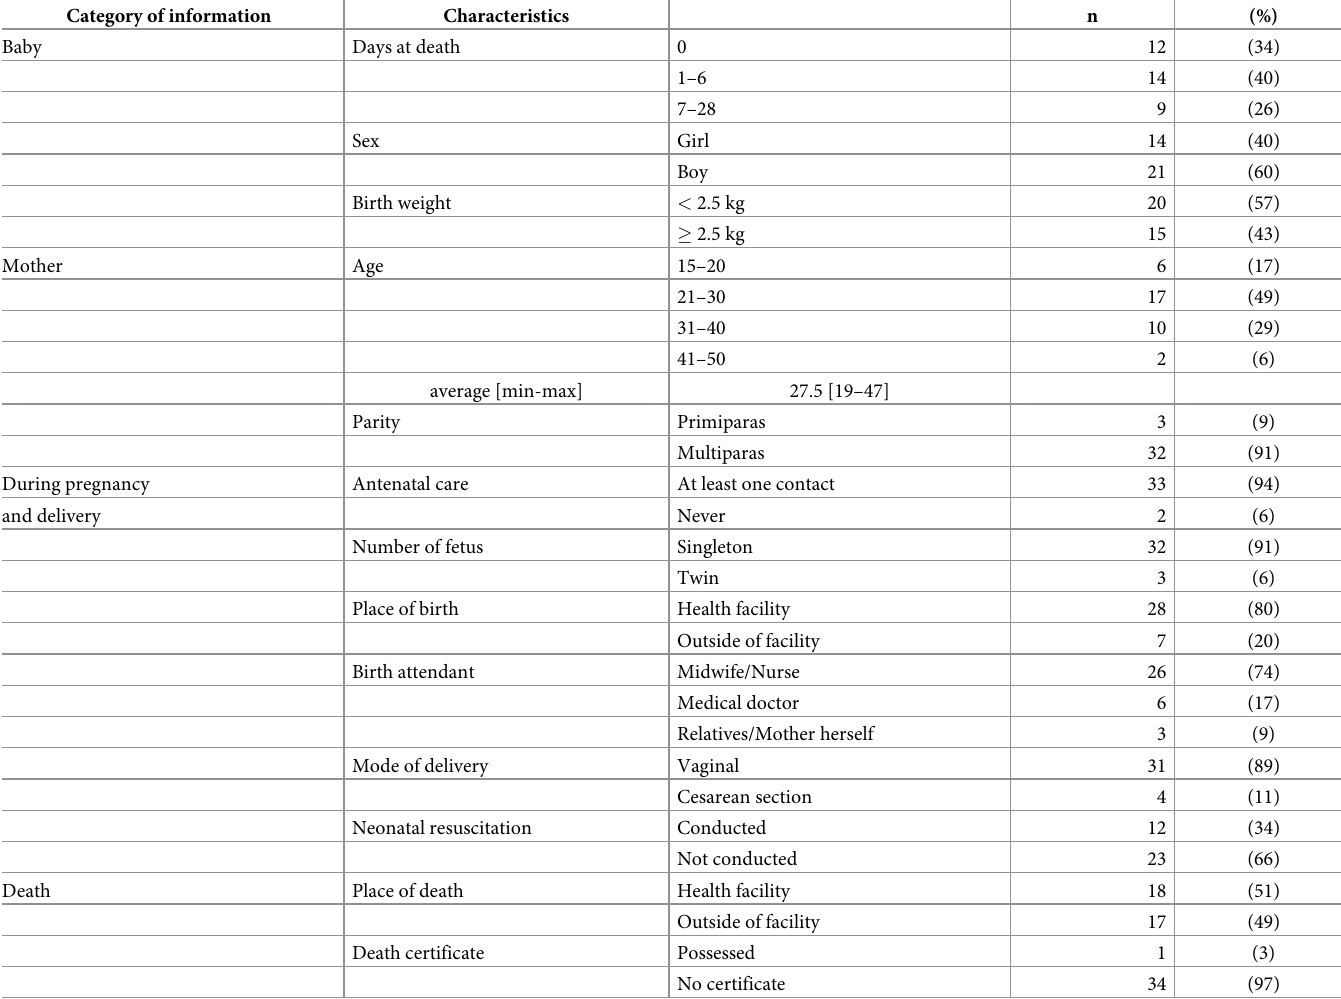
Table 2. Characteristics of neonatal deaths cases in Kampong Cham and Svay Rieng provinces, between 2015 and 2016 (n = 35). Category of information